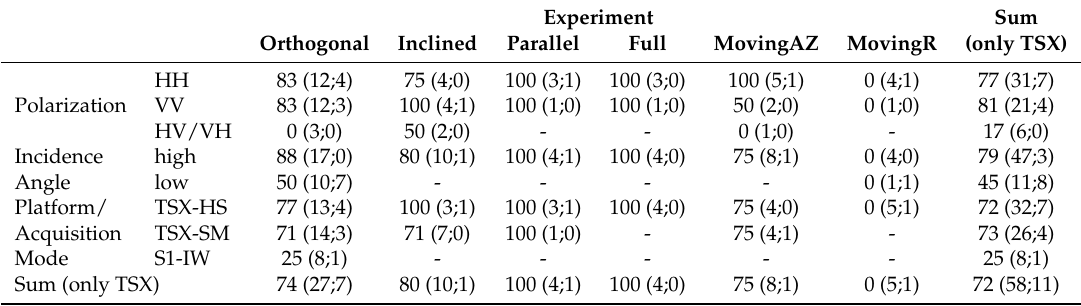
Table 5. Identification rate according to scene and sensor parameters: positive identification in % (datasets available, which suffer from increased